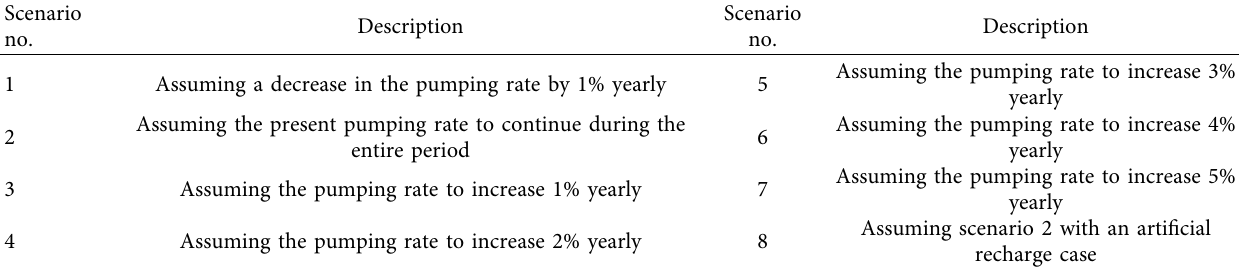
Table 2: Future scenarios for pumping